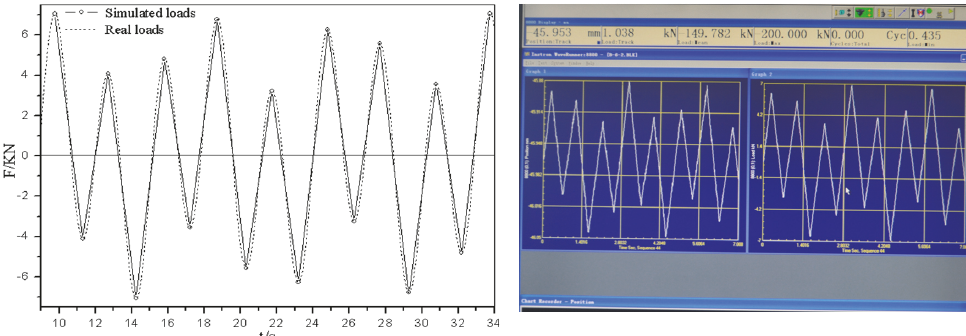
Figure 10: Detailed loading of combined process.